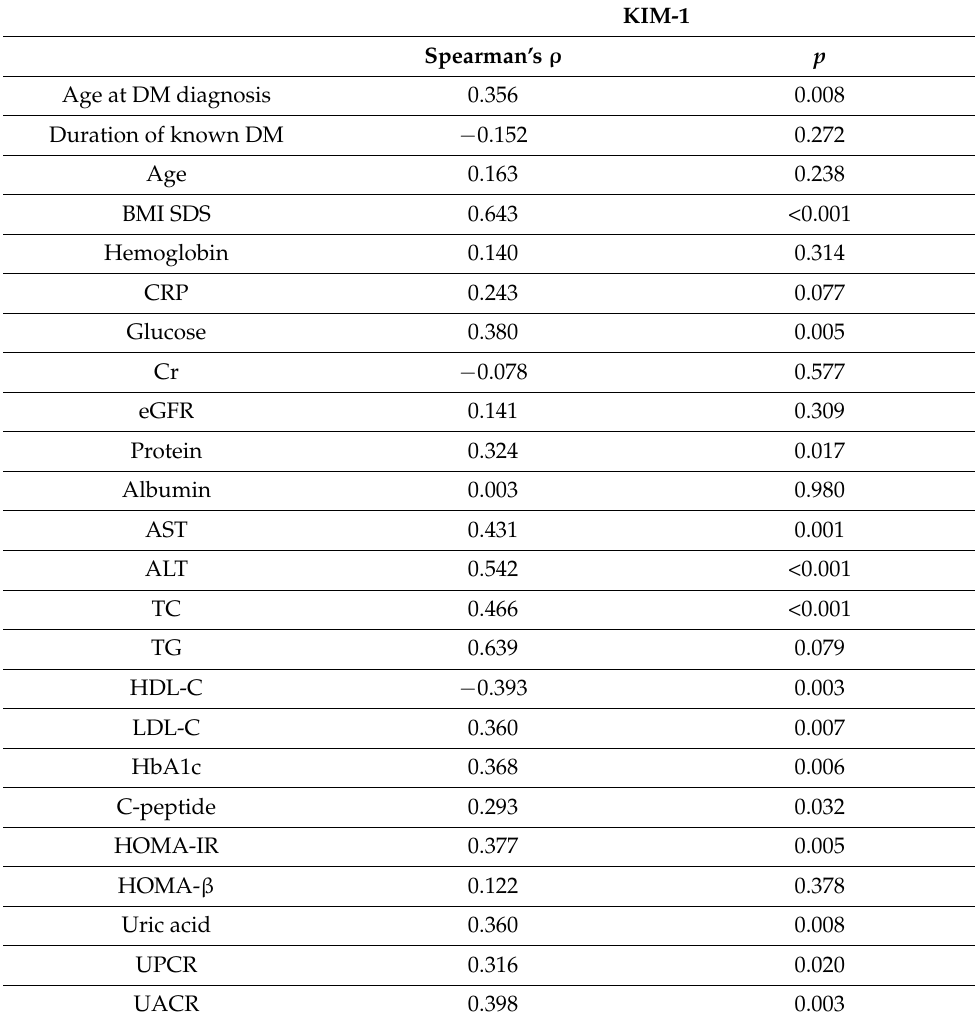
Table 3. Spearman’s rank correlation of plasma kidney injury molecule-1 with clinical and laboratory characteristics of diabetic